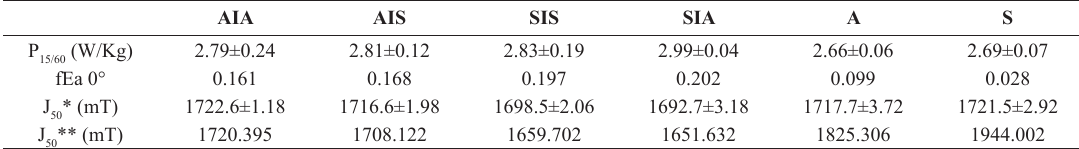
values for samples rolled 50 **. 50